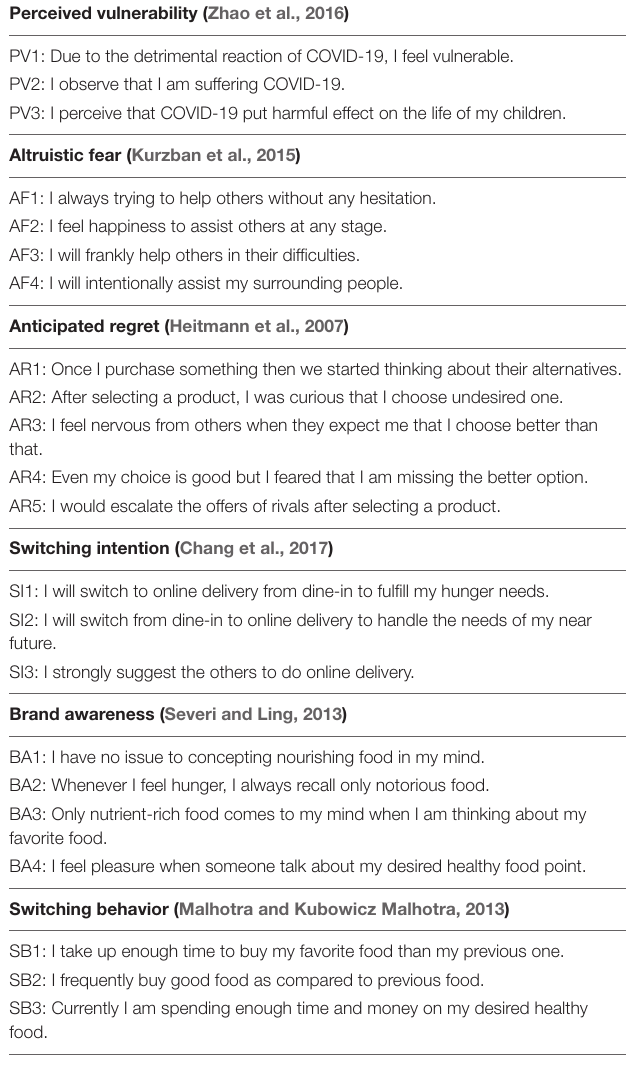
TABLE 2 | Measurement